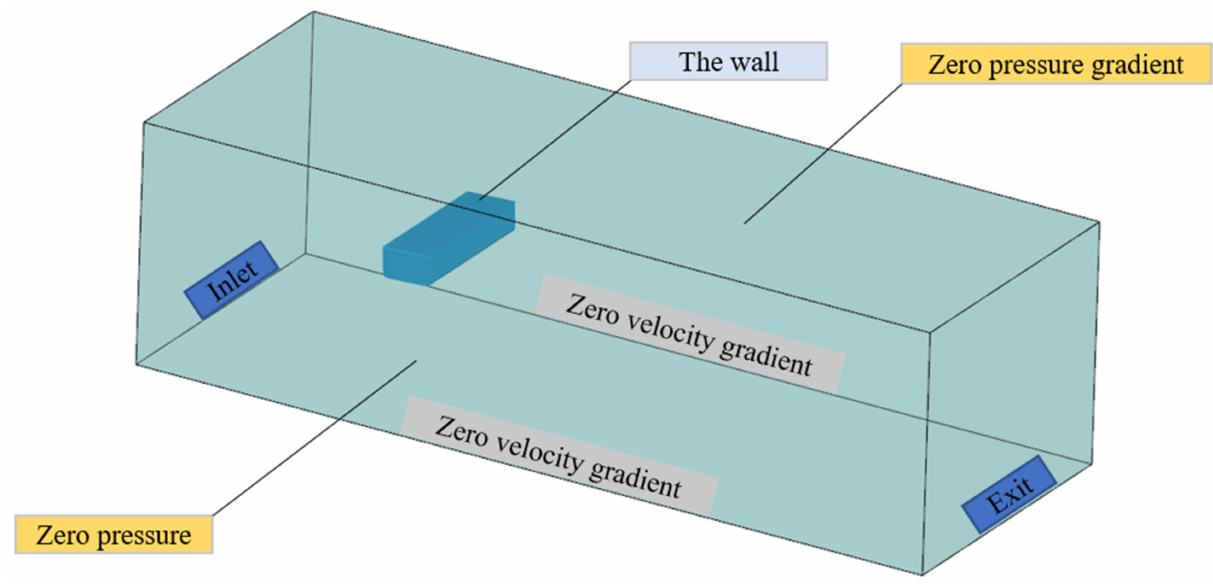
Figure 8. Computational domain and boundary